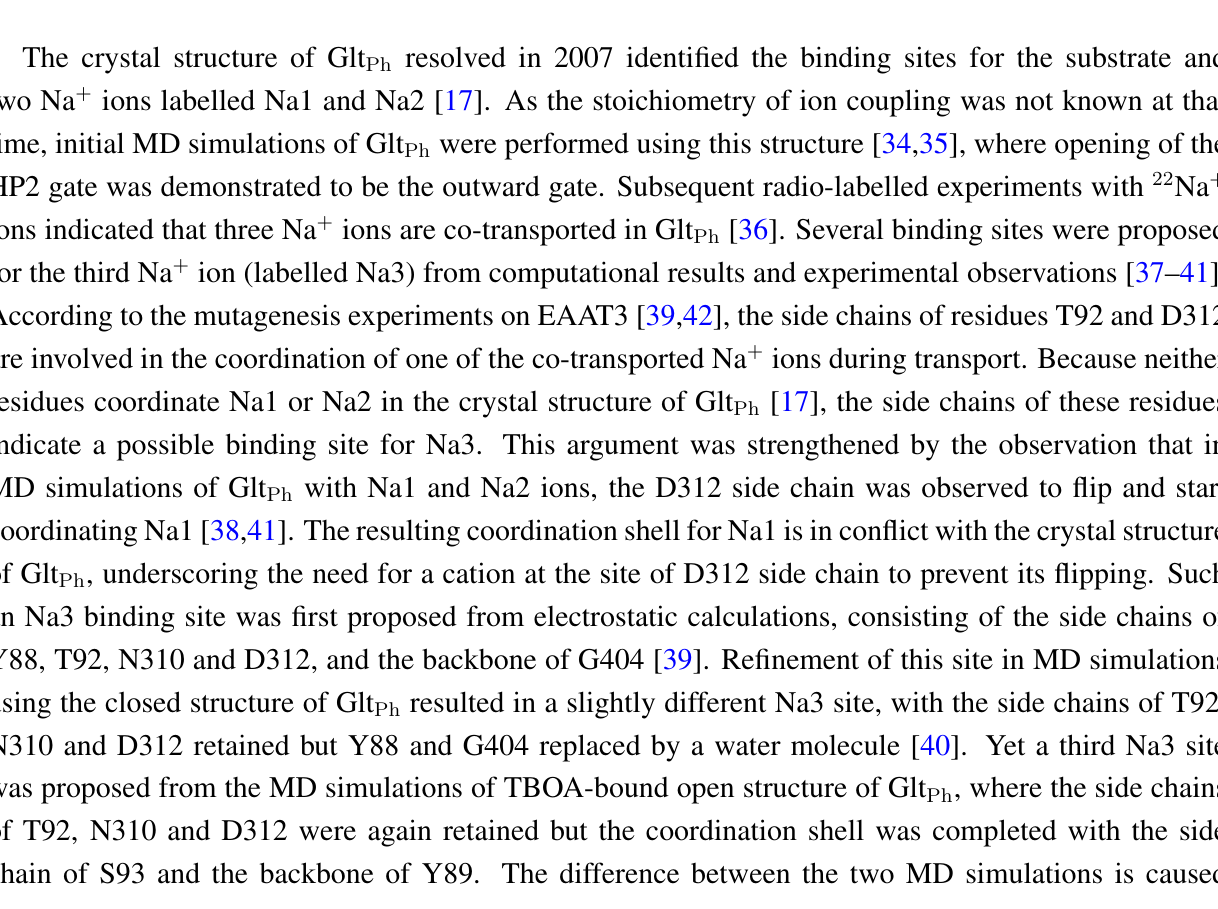
Figure 2. Transport domain of a subunit of Glt depicting the positions of Asp and three Ph Na + ions (green spheres numbered from 1 to 3). The TM segments and hairpins involved in the coordination of Asp and Na + ions are indicated as follows: HP1 ( yellow ); HP2 ( red ); TM3 ( blue ); TM7 ( orange ) and TM8 ( magenta ). Upward motion of HP2 opens the outward gate and exposes the ligands to